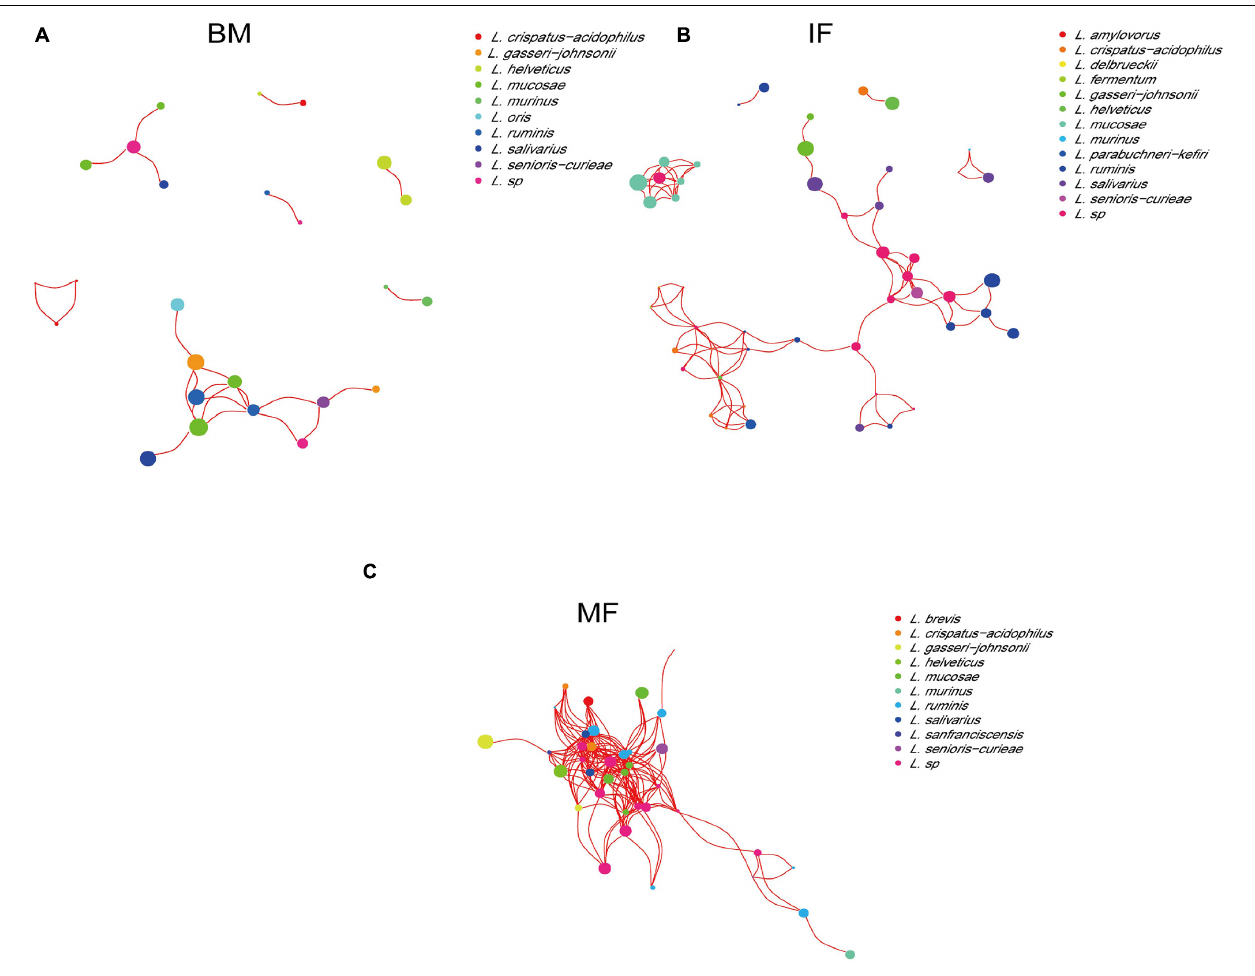
FIGURE 3 | The co-occurrence networks of lactobacilli based on 16S rRNA MiSeq Illumina sequences among the breast milk (A) , infant fecal samples (B) , and maternal fecal samples (C) . Nodes and node sizes represent Lactobacillus species and their relative abundances, respectively. Red lines represent positive correlations between the